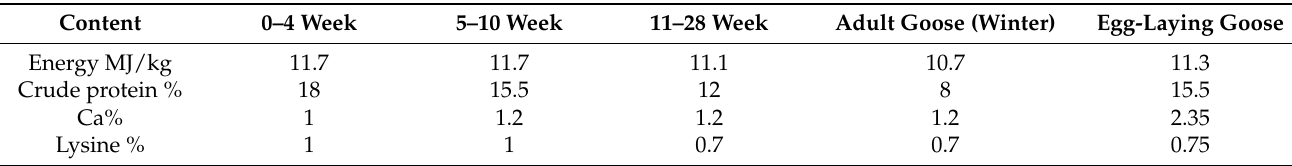
Figure 1. Schematic diagram of Zhedong and Zi crossbred goose experiment. Purebred Zhedong geese were introduced in Xiangshan County in 2016 and 2019. The Zi goose is a local variety in Heilongjiang. The F1, F2 and F3 hybrids were obtained through hybridization, and some experimental populations were selected to measure body weight and laying rate as well as for whole genome resequencing analysis. If the primary generation Zhedong goose was homozygous for site AA, then gene type AB and AA could appear in the F2 and F3 generations. However, BB type was not possible. Table 1. Goose Feed Nutrition Standard.